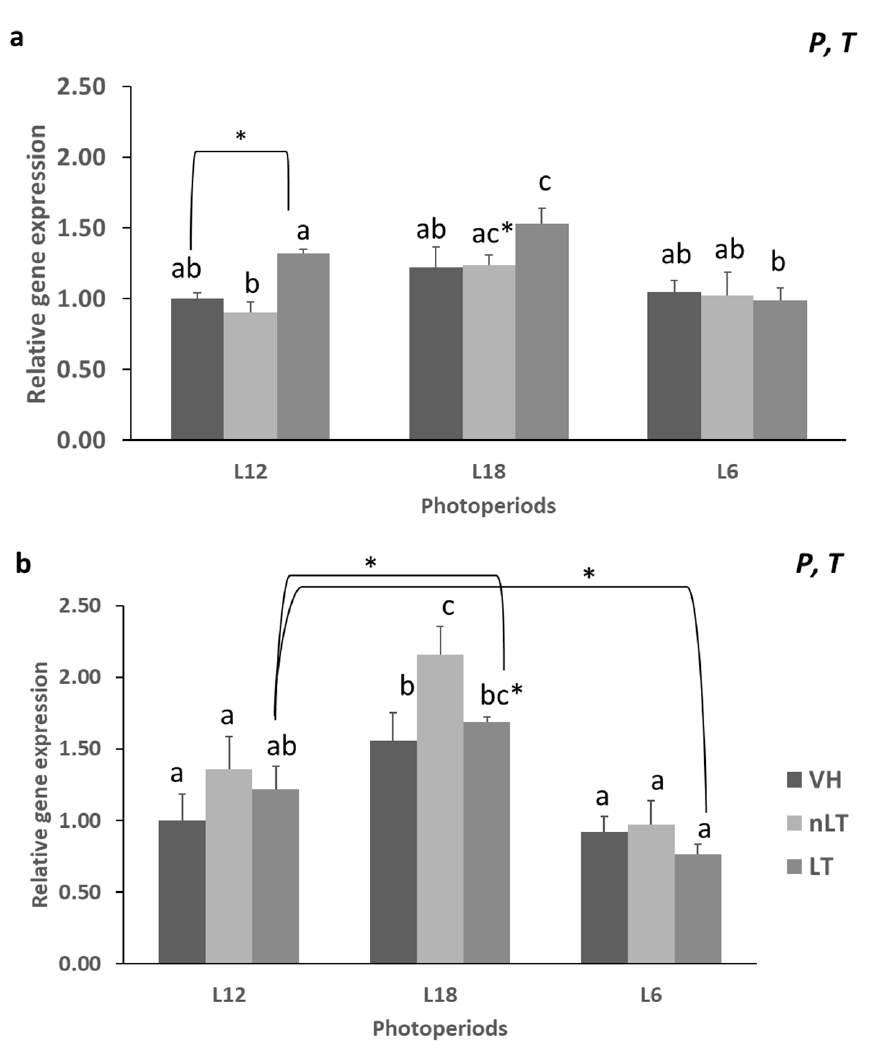
Figure 1. The mRNA levels of acetyl-coenzyme A carboxylase ( Acc1 ) ( a ) and fatty acid synthase ( Fas1 ) ( b ) of male Fischer 344 rats treated for 7 weeks with vehicle (VH), non-Local tomatoes (nLT) or Local (LT), and exposed to different photoperiods (short: L6, standard: L12 or long: L18). Values expressed as mean ± SEM ( n = 8). The values were normalized by the L12-VH group. P, photoperiod effect; T, treatment effect (two-way ANOVA, p < 0.05). Different letters above the bars indicate significant differences ( p < 0.05) (post hoc DMS, one-way ANOVA). * Indicate trend (0.05 < p < 0.1). of the photoperiod was observed in L18 since L18-VH, L18-nLT, as well as L18-LT group